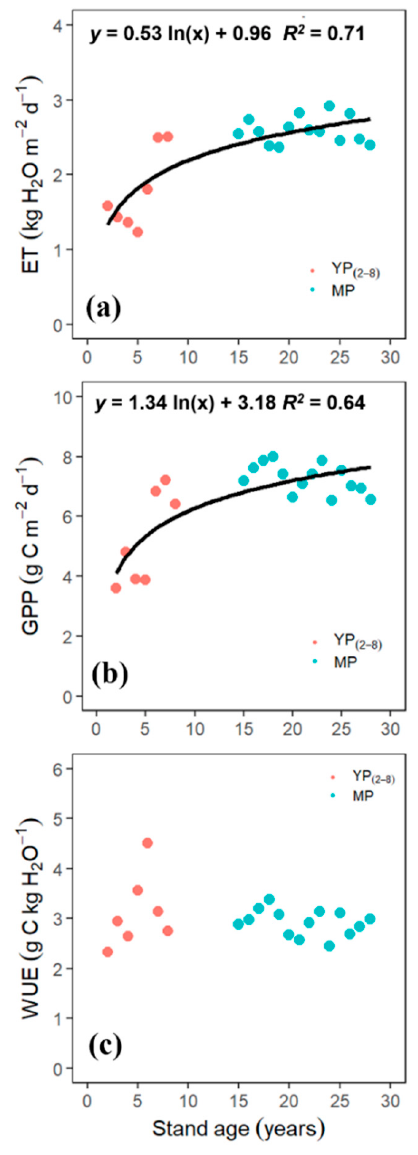
Figure 5. Regression curves between stand age and ( a ) evapotranspiration (ET), ( b ) gross primary productivity (GPP), and ( c ) water use efficiency (WUE) at YP and MP. Annual ET, GPP, and WUE were represented by circles colored according to site.